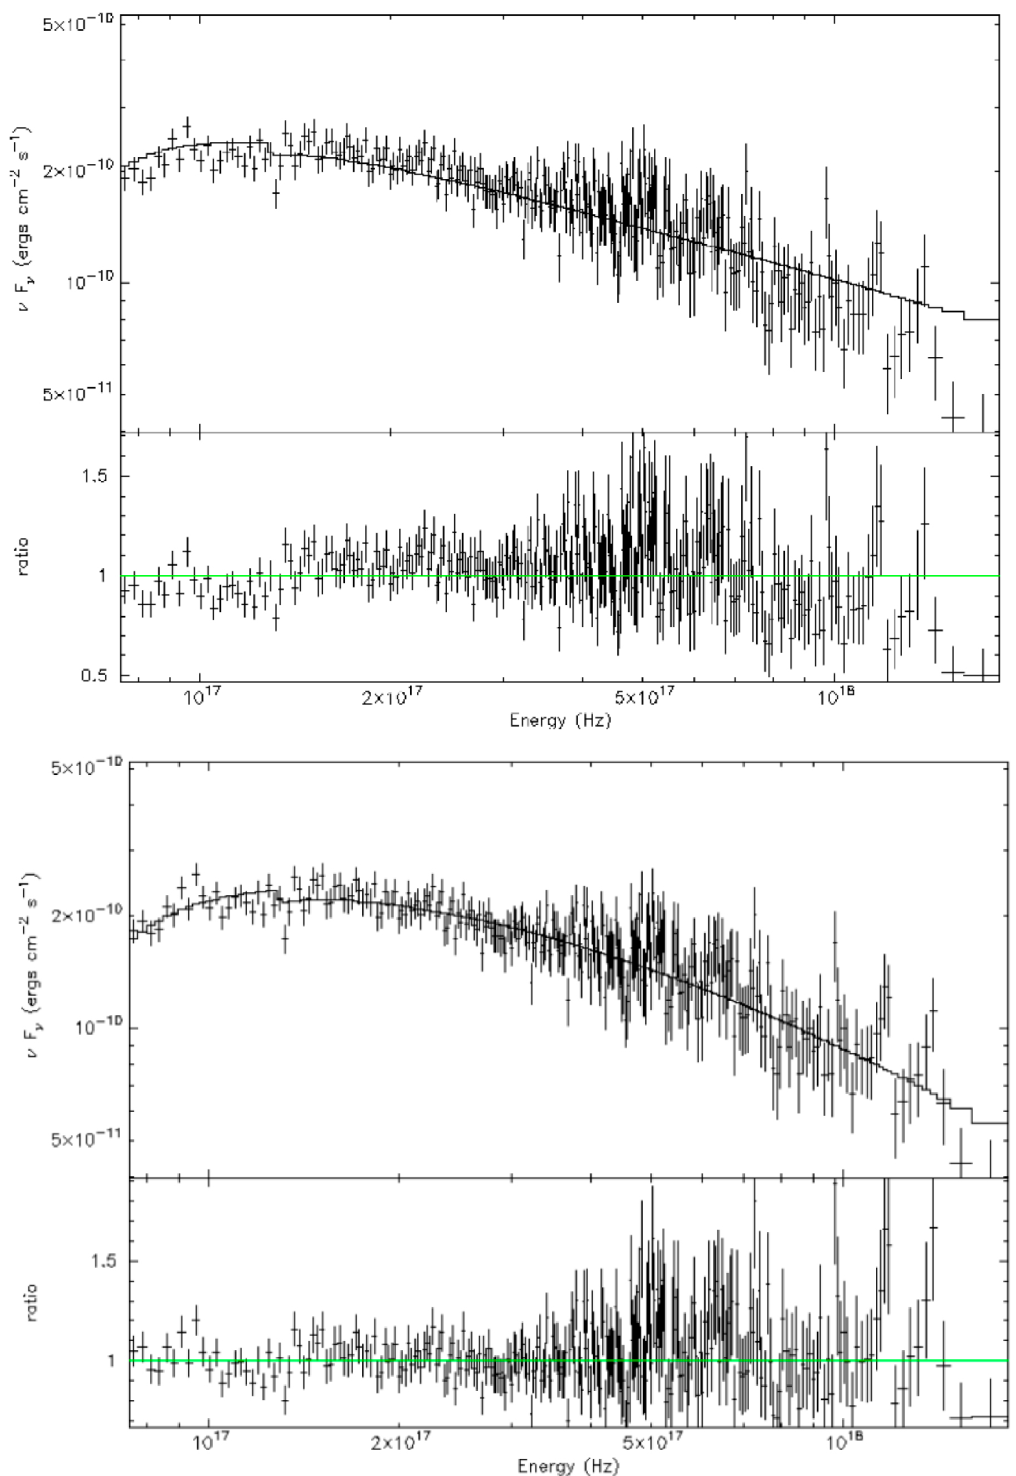
Figure 1. Upper panel : A simple power-law (left) fit to the 0.3–10 keV spectrum of Mrk 421 extracted from the observation ObsID 00030352115 (24 March 2009) made by X-ray Telescope onboard the satellite Swift, yielding the reduced Chi-squared ( χ 2 r ) value of 1.40 with 270 degrees-of-freedom (d.o.f.) and a prominent trend in the residuals. In the lower panel , the same spectrum is fitted with the log-parabolic model, yielding χ 2 r = 1.09 with 269 d.o.f., and the distribution of the fit residuals show that the model is acceptable for this spectrum. It shows a significant curvature with b = 0.30 ±